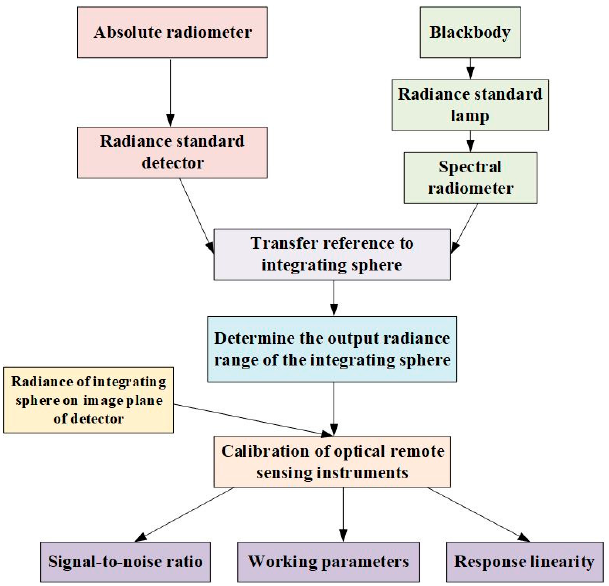
Figure 2. Transmission of radiation standards. The integrating sphere light source is used to simulate the actual observation target for image acquisition. The ratio of the statistical average gray value of each pixel of the remote sensing instrument is calculated row by row to obtain the statistical root mean square noise, that is, the signal ‐ to ‐ noise ratio (SNR) of the pixel under this lighting condition: